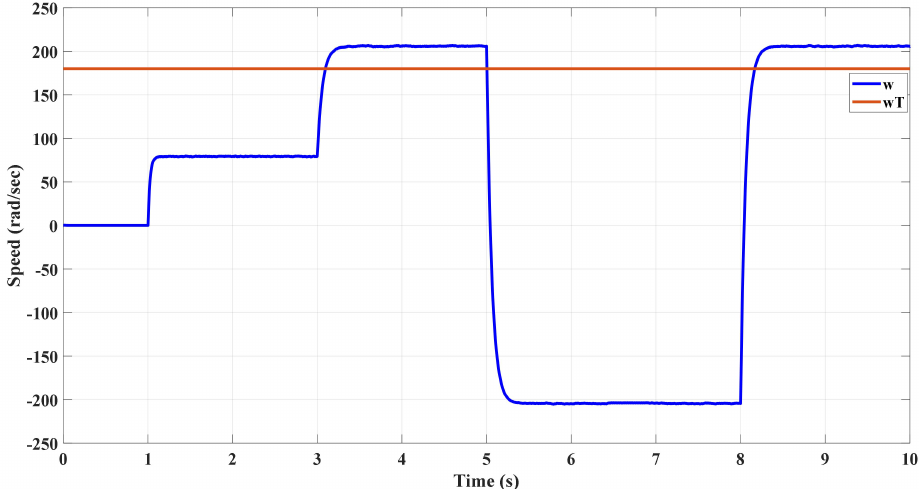
Figure 12. Motor speed and ω T for the conventional and improved strategies.